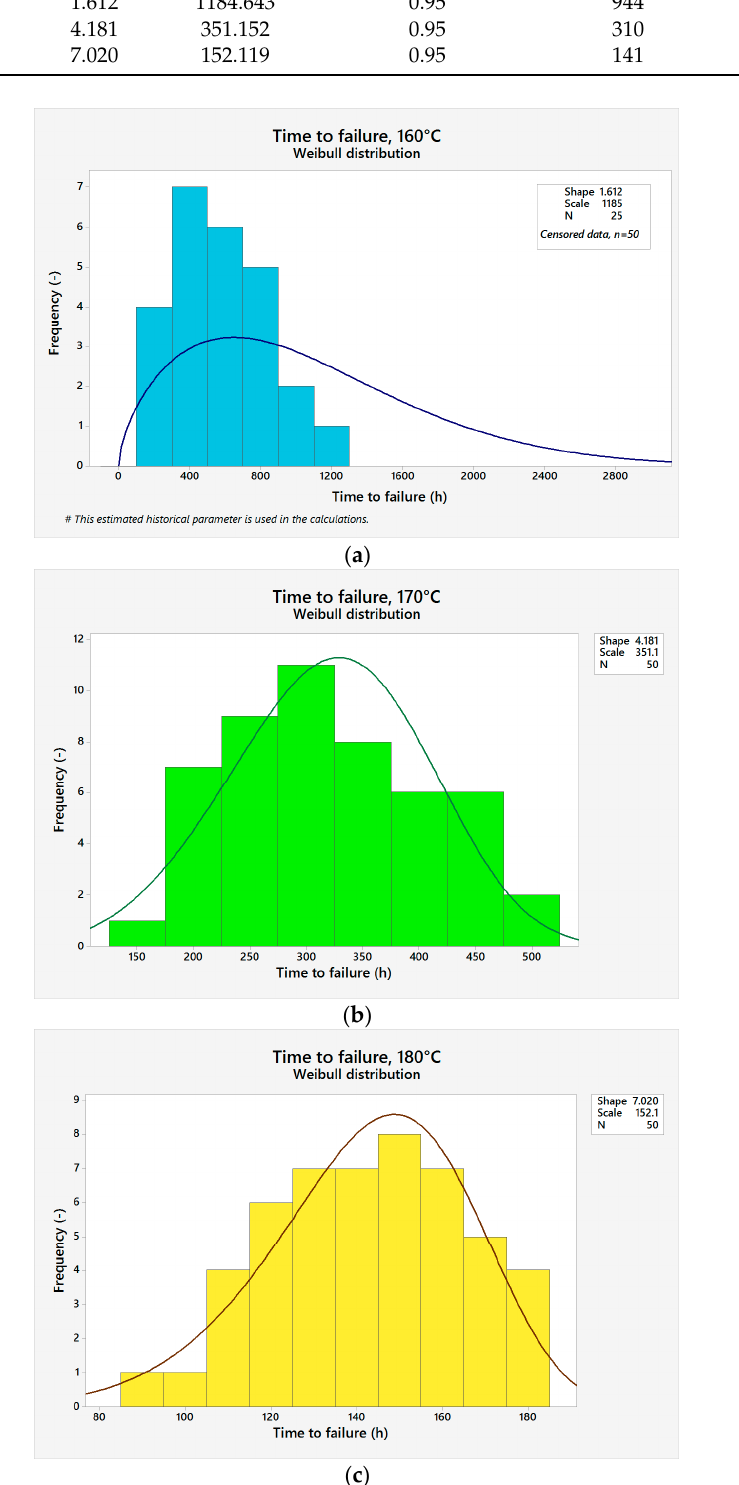
Figure 8. Histograms for time to failure of the transformer board at the selected temperatures: ( a ) 160 °C; ( b ) 170 °C; and ( c ) 180 °C.